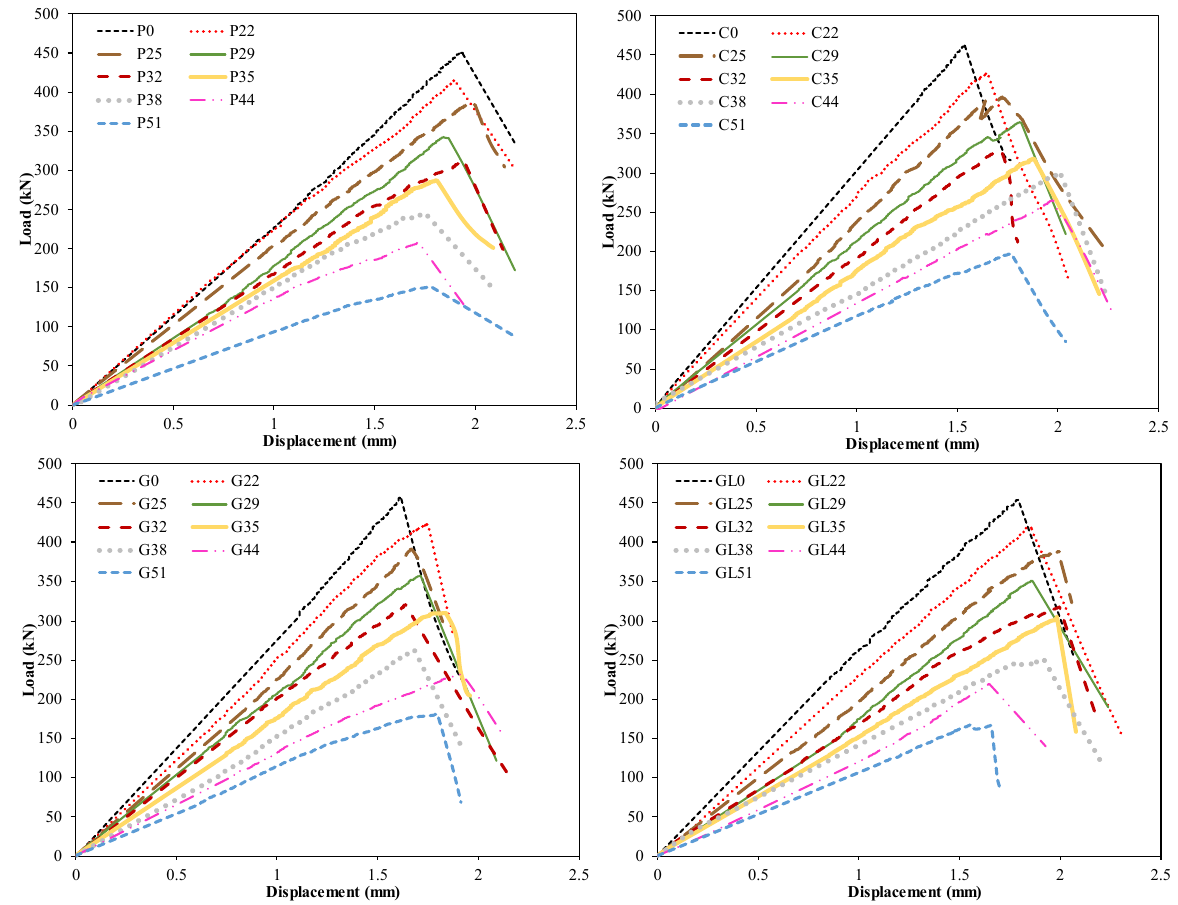
Figure 4. Load–displacement curves of openings with different opening sizes. Table 3. Results of the specimens with different hole sizes.